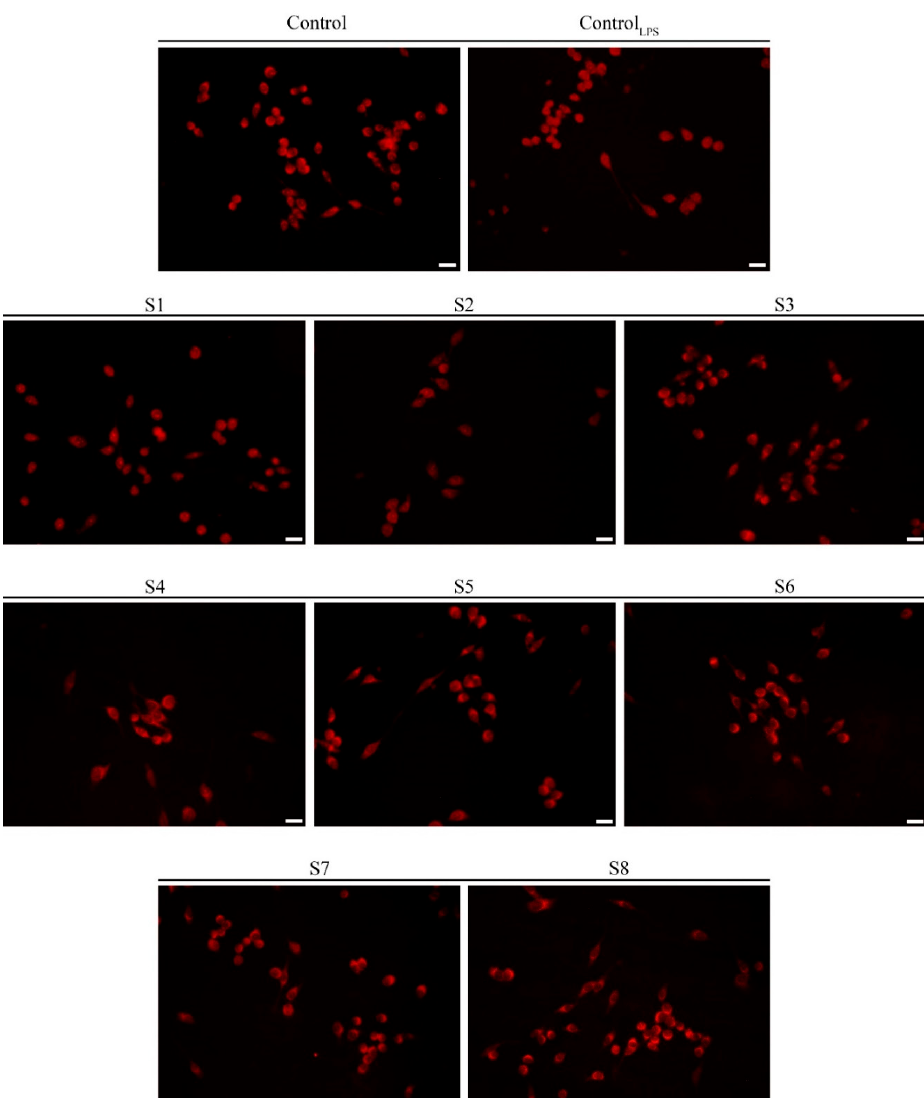
Figure 5. Salvia officinalis extracts interfere with the NF- κ B nuclear translocation in RAW 264.7 cells. Immuno-fluorescent detection of NF- κ B in cells treated with DMSO (control) or 1 µg/mL LPS + DMSO (control LPS ) or 1 µg/mL LPS + S1–S8 extracts (as indicated), at their IC 50 , for 1 h. Scale bar: 50 µm.